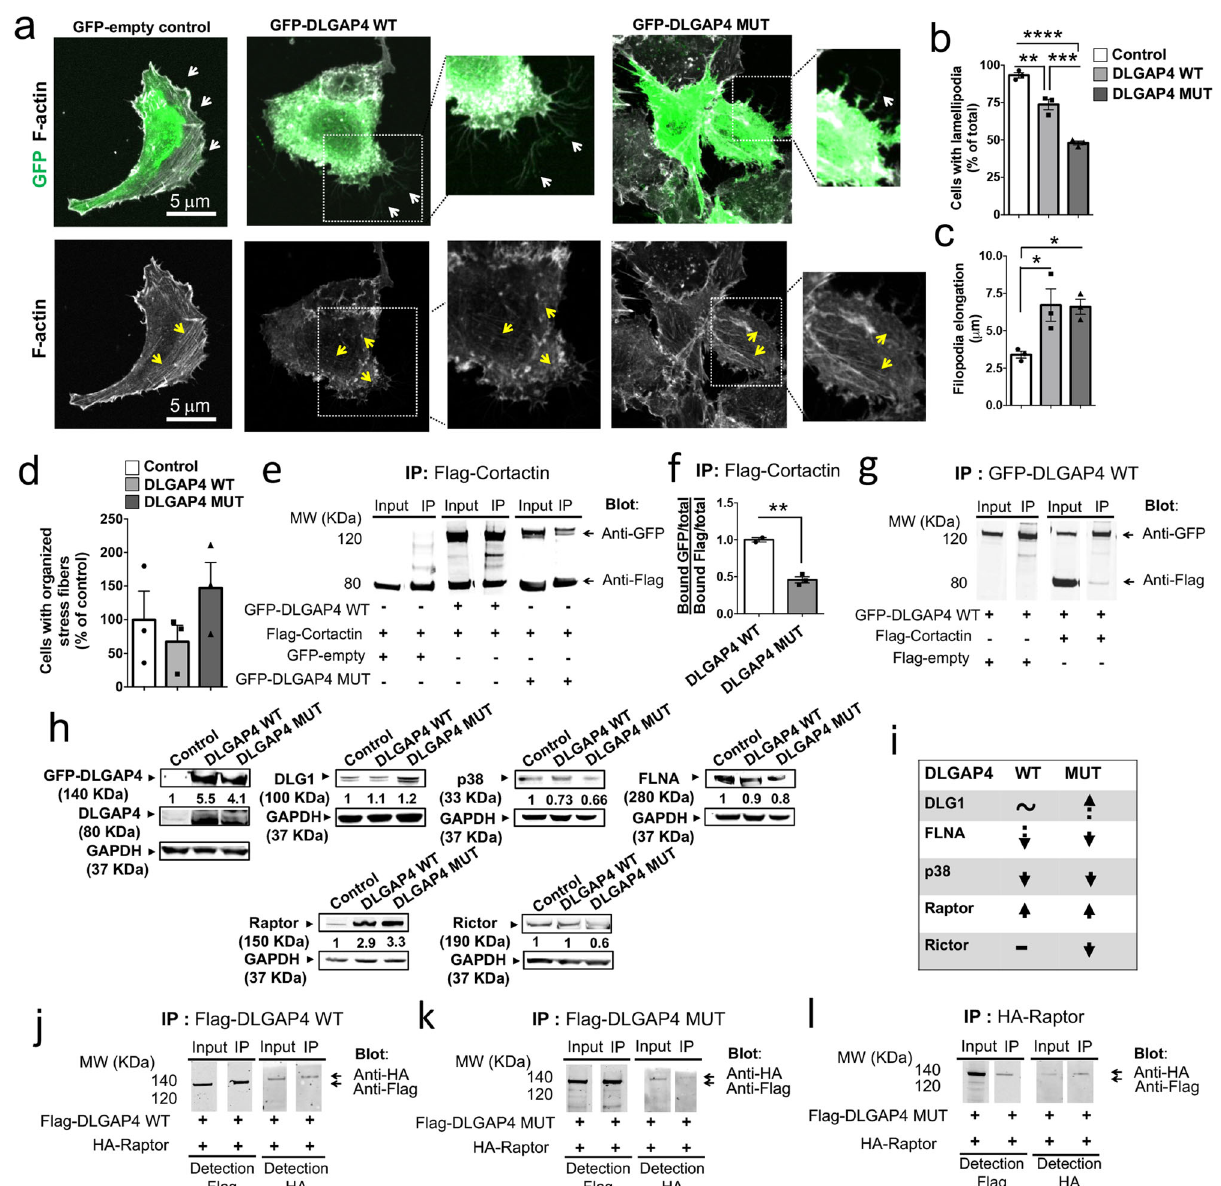
Fig. 7 DLGAP4 OE impacts actin cytoskeleton dynamics in vitro and may in fl uence the downstream mTOR pathway. a Representative RPE1 cell images showing reduced lamellipodia morphology and increased fi lopodia elongation (white arrows) after WT or mutant DLGAP4 transfections. Yellow arrows: F-actin. b Quanti fi cations of cell percentages with lamellipodia morphology, c fi lopodia elongation ( µ m) and d organized stress fi bers. Quanti fi cation data ( b – d ) represents the individual values, mean ± SEM (~100 cells per condition, n = 3 independent experiments). One-way ANOVA with post hoc Tukey ’ s test was performed. b F 2, 6 = 88.8, p < 0.0001; ** p = 0.0029, ***p = 0.0007, ****p < 0.0001. ( c ) F 2, 6 = 7.21, p = 0.025; Ctl vs WT DLGAP4 : *p = 0.036 and Ctl vs MUT DLGAP4 : *p = 0.041. d F 2, 6 = 1.25, p = 0.35. e IP performed from N e uro2A cells co-transfected with Flag-cortactin and GFP- DLGAP4